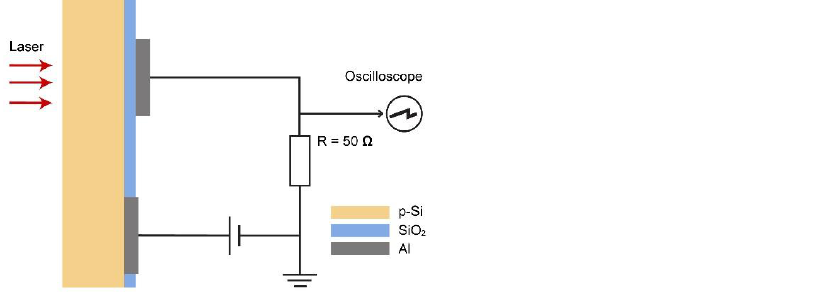
Figure 1. Schematic of the Al-SiO 2 -p-Si sample and the circuit of photocurrent measurement.